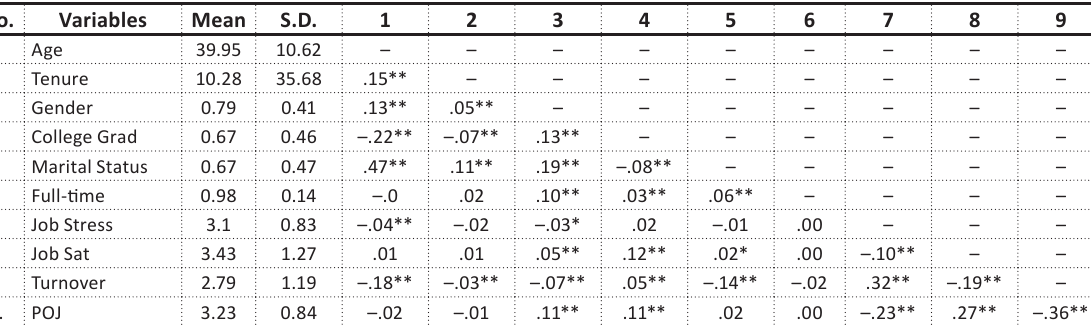
Table 1. Descriptive statistics and